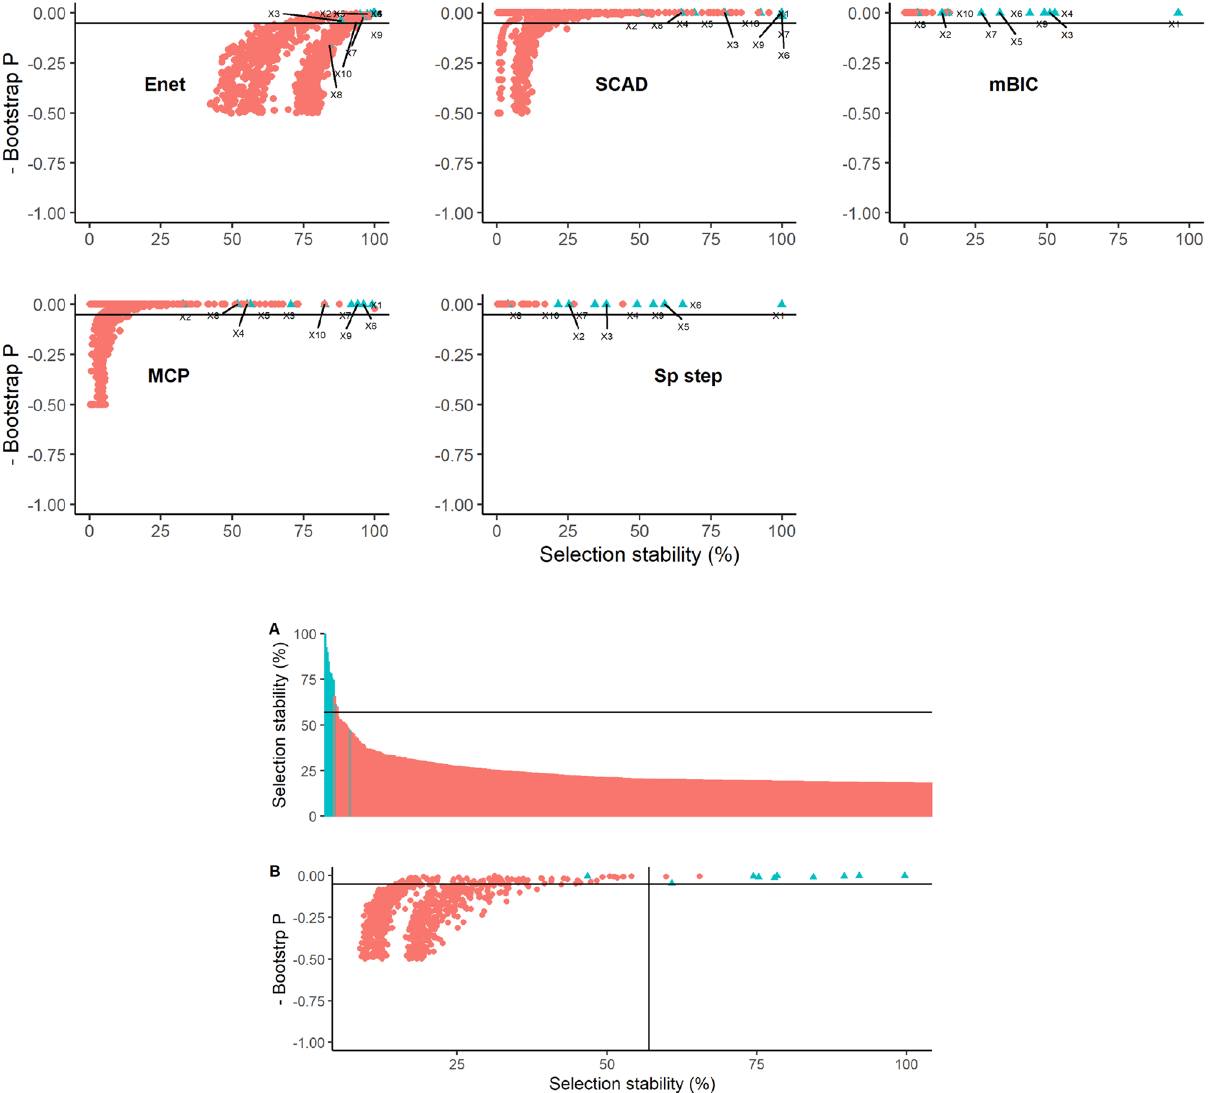
Figure 2. Graphical illustrations of bootstrap results from Dataset 1 using five methods of covariate selection. Graphs depict scatterplots of negative bootstrap P value against covariate selection stability except for Graph A that is an ordered plot of covariate selection stability in descending order for the combined model aggregating all five methods. The lines on graphs A and B represent the calculated threshold to determine a cut-off for ‘important’ covariates. The ‘true’ underlying covariates are coloured blue and labelled rate of change of selection stability > 1 to identify a threshold above which variables were deemed ‘important’ (Fig. 2), nine of the ten true variables would be selected as important (FNER = 10%) and two false variables would incorrectly be identified as positive (FPER = 0.2%); this compared favourably with the error rates of full models of the different methods presented in Table 1. The coefficient distributions of the combined method are illustrated in Fig. 1. These distributions showed a good coverage of the true covariate distributions although were generally slightly conservative (wider) than those in the true underlying model. The combined distributions represent a non-parametric, weighted average across models and since they were estimated from covariates selected in each bootstrap sample, they were effectively weighted by selection stability of each method. These combined coefficients therefore represent the combined uncertainty in covariate estimates arising from variability between method. Covariate selection stability and bootstrap P values estimated for Dataset 2 are illustrated in Fig. 3. With the stronger signal, all methods performed better than with Dataset 1 with the true variables generally being most stable and with low bootstrap P values. All methods had difficulty in differentiating true covariate X2 (the covari- ate with the smallest true effect size and true confidence interval closest to zero) and elastic net and SCAD tended to select false variables more commonly in bootstrap samples than other methods. The combined stability and bootstrap P values calculated across all methods are also displayed in Fig. 3. The combined method provided a clear separation of the true variables with the exception of variable X2 that was problematic for each method.